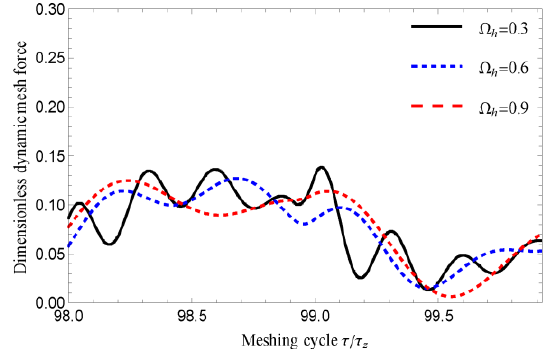
Figure 20. Dynamic mesh force of a single pair of teeth under different 𝛺 ℎ .